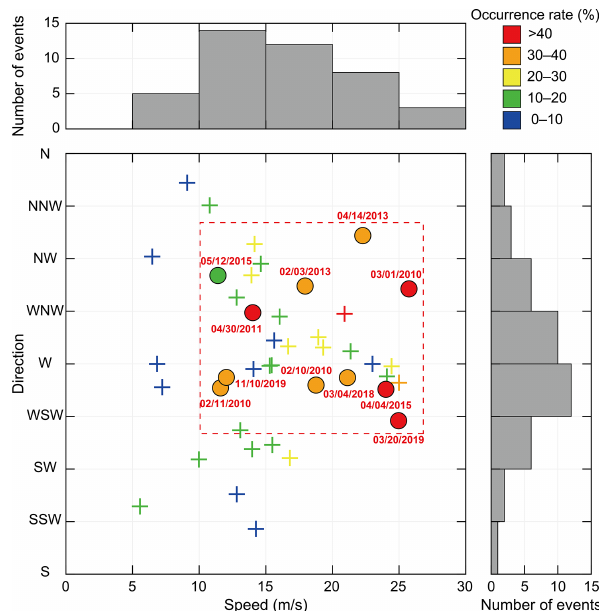
Figure 9. Propagation pattern of air pressure jumps during the clas- sified meteotsunami events (speed, direction, and occurrence rate). Colors of circles and crosses indicate occurrence rate of the air pres- sure jump during the 11 extreme events and the remaining 31 me- teotsunami events, respectively. The red dashed square in the scat- terplot encloses the range of speed and direction for the air pressure jumps during the extreme (widespread) meteotsunami events. The binned distributions of direction and speed are